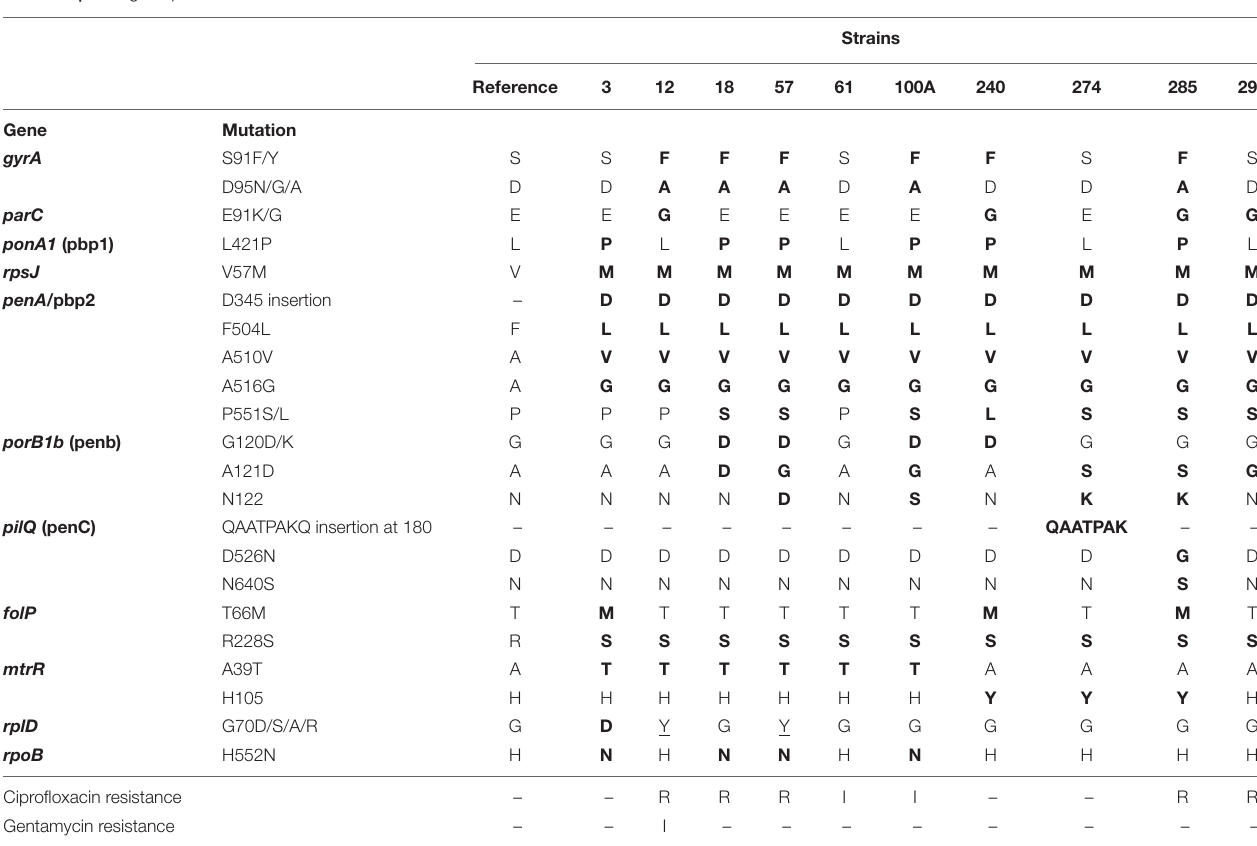
TABLE 3 | AMR gene profile of the 10